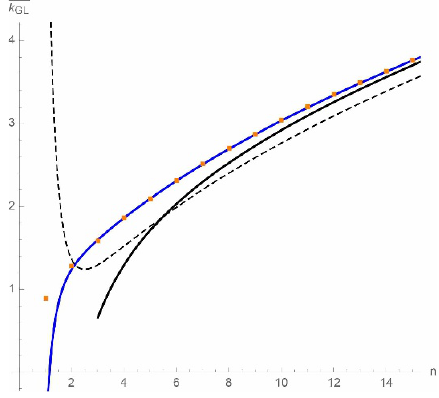
Figure 4 . Onset of the Gregory-La(cid:13)amme instability (cid:22) k GL = k GL r 0 as a function of n as predicted by di(cid:11)erent methods for (cid:12) = 0: (cid:12)rst order blackfold approach (black dashed line), second order blackfold approach (black solid line), fourth order large D approach [40] (blue solid line) and numerical points of [39] (orange